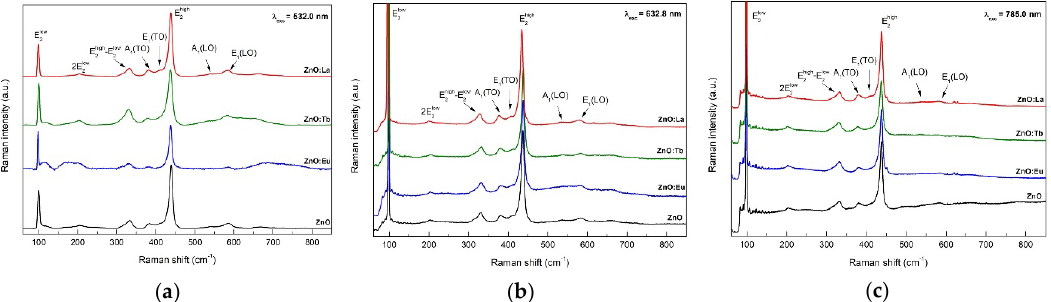
Figure 11. Raman spectra of ZnO, ZnO:Eu, ZnO:Tb, and ZnO:La under 532.0 nm ( a ); 632.8 nm ( b ); and 785.0 nm ( c ) excitation wavelength.